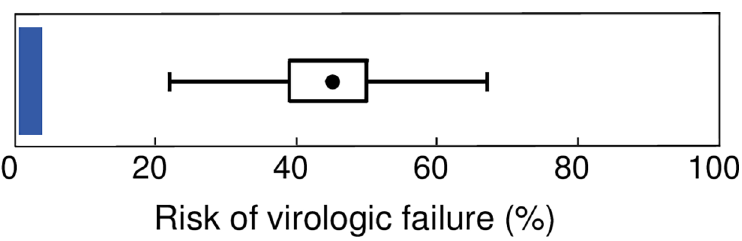
Fig 6. Boxplot of the risk of virologic failure as predicted by the model and obtained from 200 simulations, one per sampling point of drug penetration values ( k lEFV , k lTFV , k lFTC ). For comparison purposes, the area shaded in darker blue is the confidence interval for the equivalent but observed in a real patient